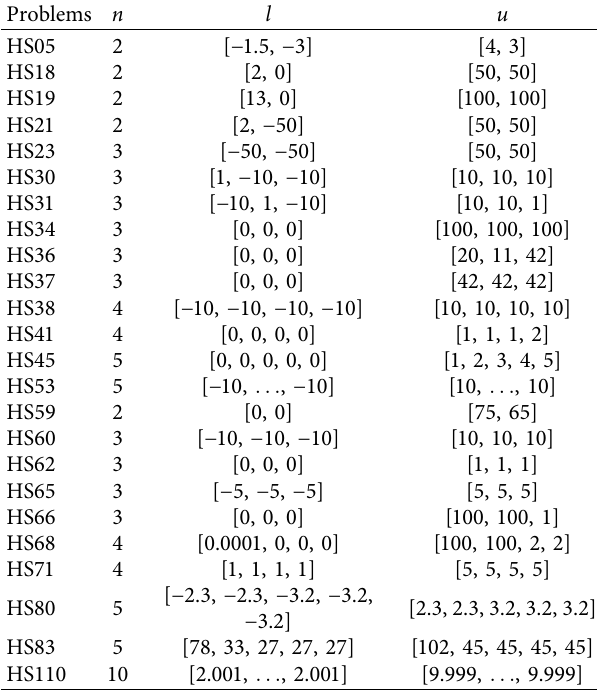
Table 1: The information of test problems.